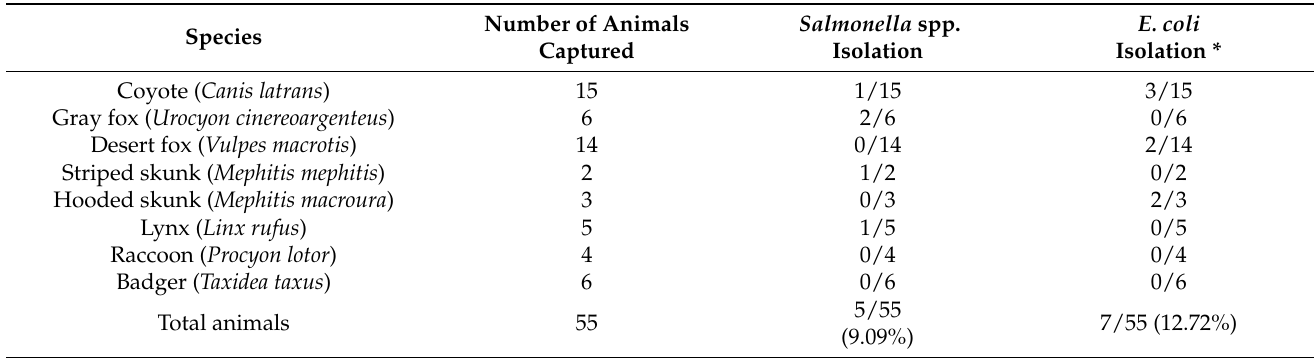
Table 1. Salmonella and E. coli isolates by species.